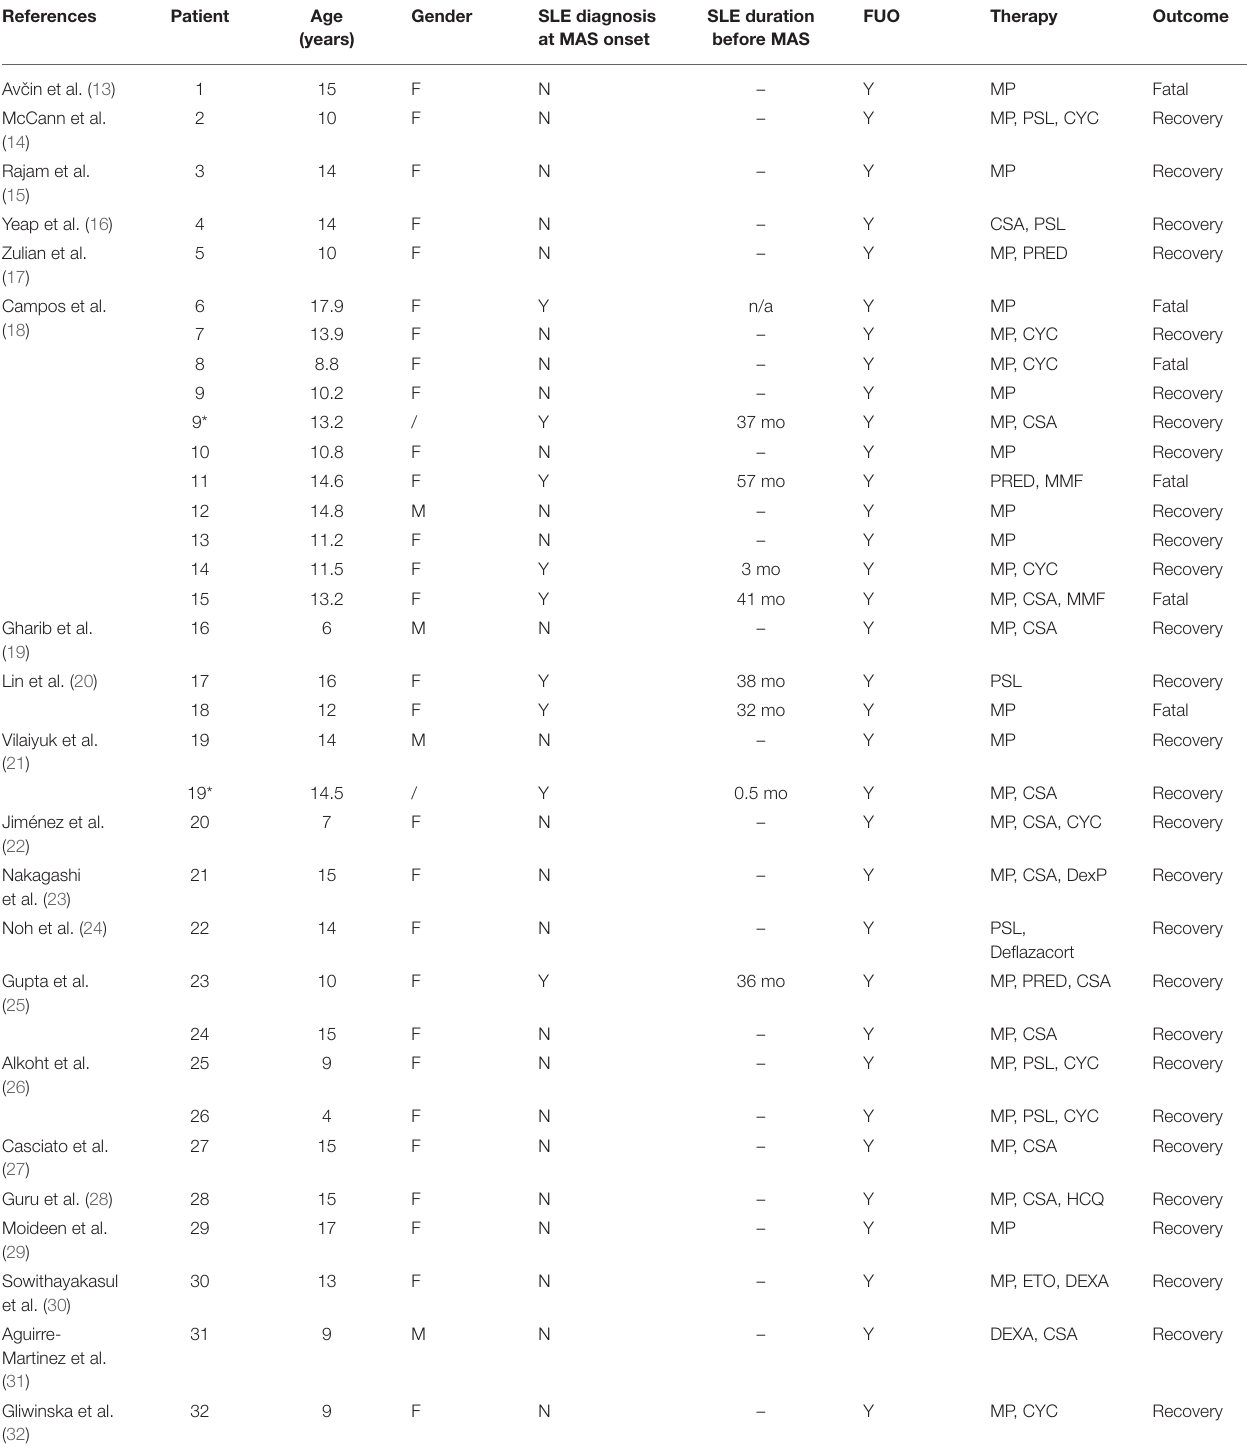
TABLE 1 | Demographics, treatment, and outcome of patients with pediatric Systemic Lupus Erythematosus (pSLE) and Macrophage Activation Syndrome (MAS) in case